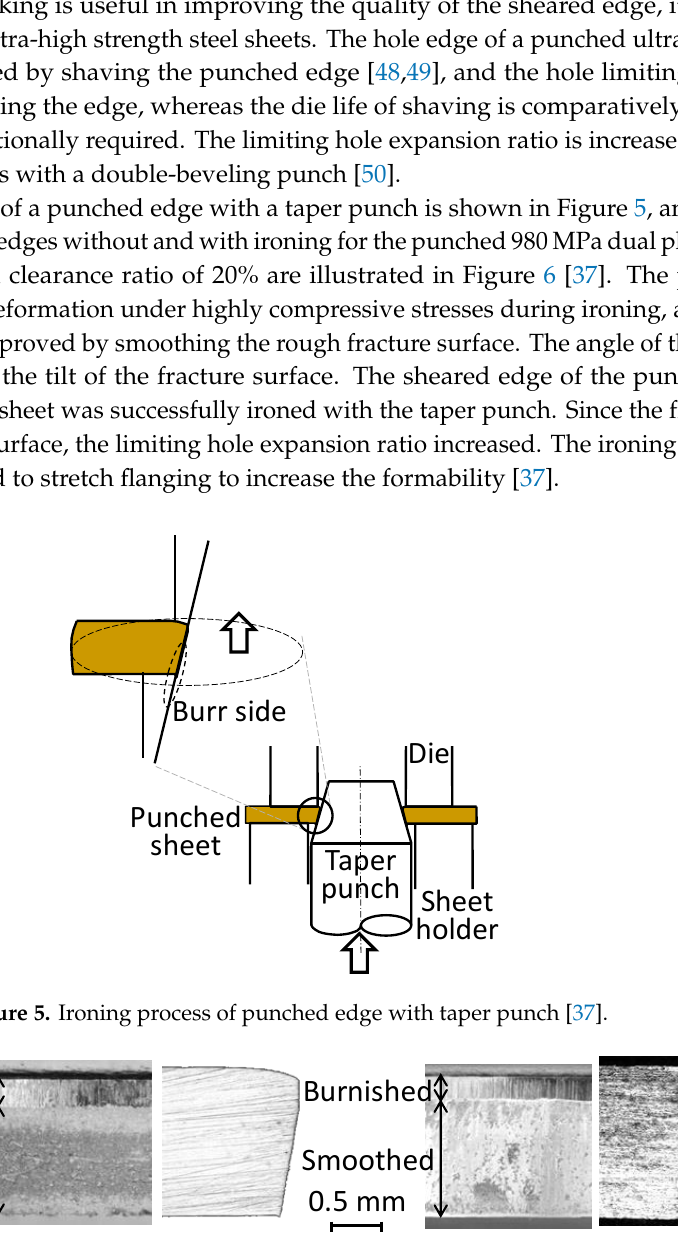
Figure 4. Surfaces of sheared edge and fatigue strength for punched ultra-high strength steel plate for ( a ) punched strength and ( b ) fatigue strength [47].